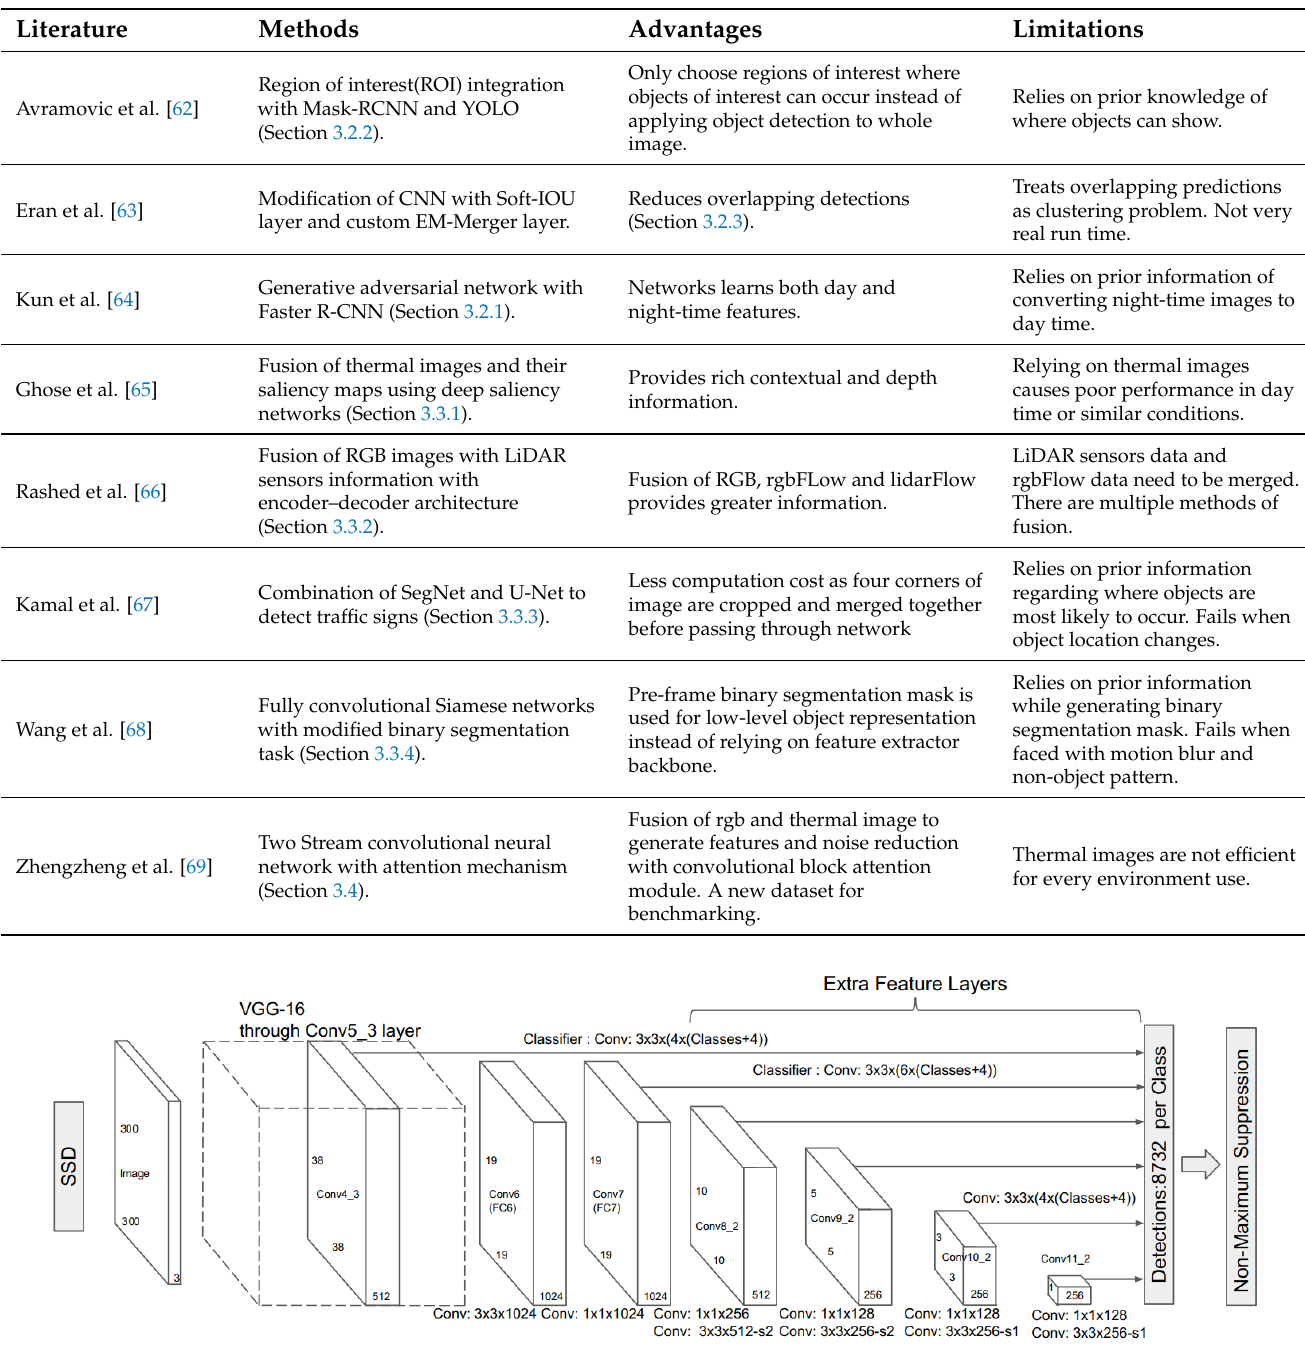
Figure 11. The explained architecture of SSD [26]. The architecture of SSD is based on the VGG-16 [70] as base network by replacing VGG fully connected layers with auxiliary convolutional layers to provide feature extraction at multiple scales. Later, the multibox detector [71] performs the task of object detection. Reprinted from